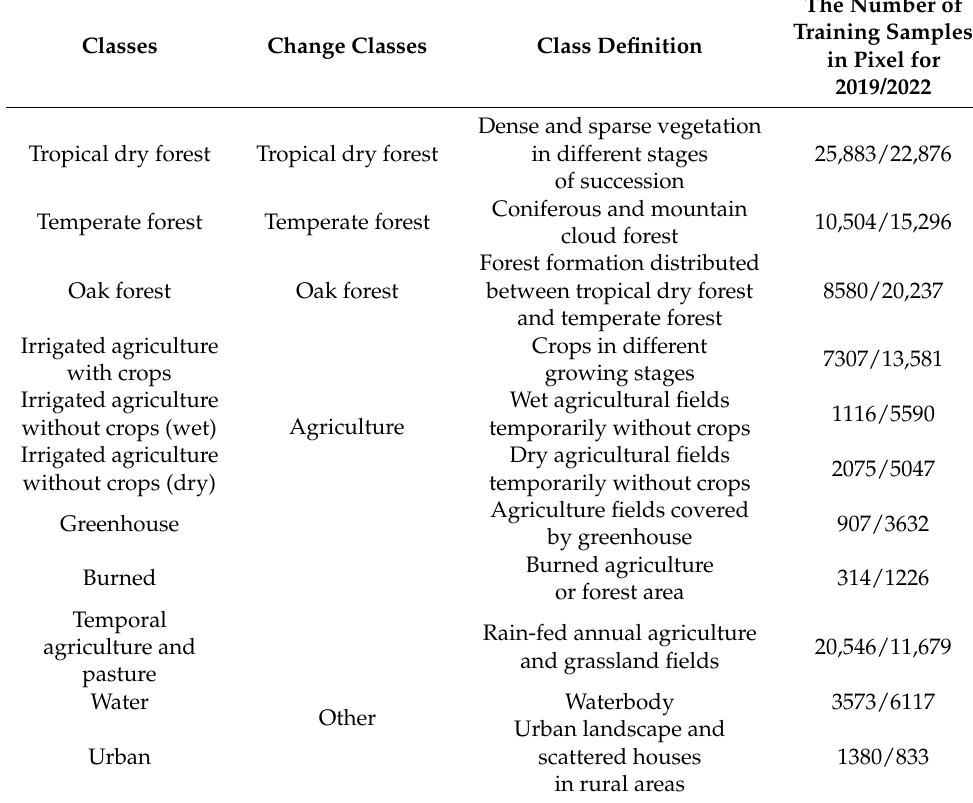
Table 2. Definition of land cover/land use classes (in reference to the INEGI series VII class